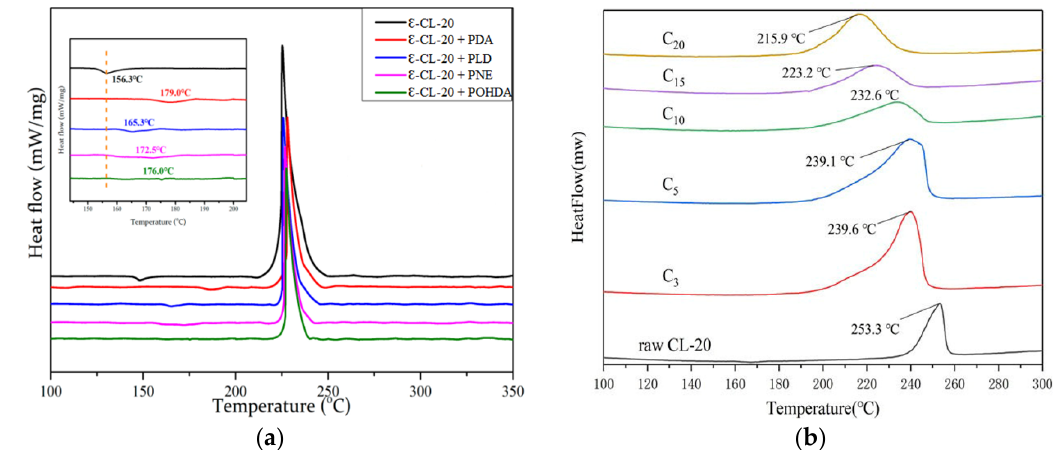
Figure 10. DSC curves for raw CL-20 and different composites (samples C 3 , C 5 , C 10 , C 15 , and C 20 in b denote that the weight ratios of CAB in the composites are 3%, 5%, 10%, 15% and 20%; the heating rate in ( a , b ) are 5 °C/min and 10 °C/min, respectively). ( a , b ) Reproduced under the terms of the CC-BY Creative Commons Attribution 4.0 International Licence